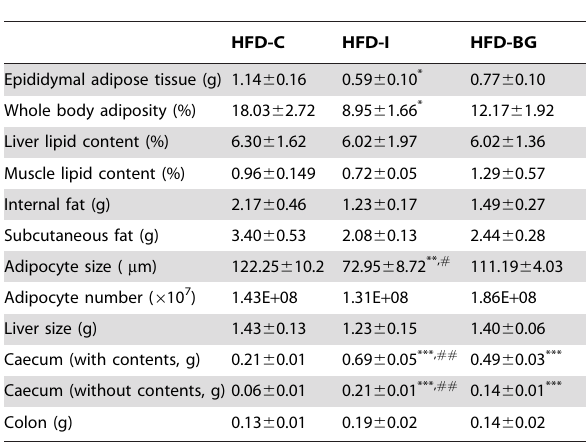
Table 1. Effect of inulin and b -glucan supplementation on adiposity parameters and tissue weights in high fat fed mice